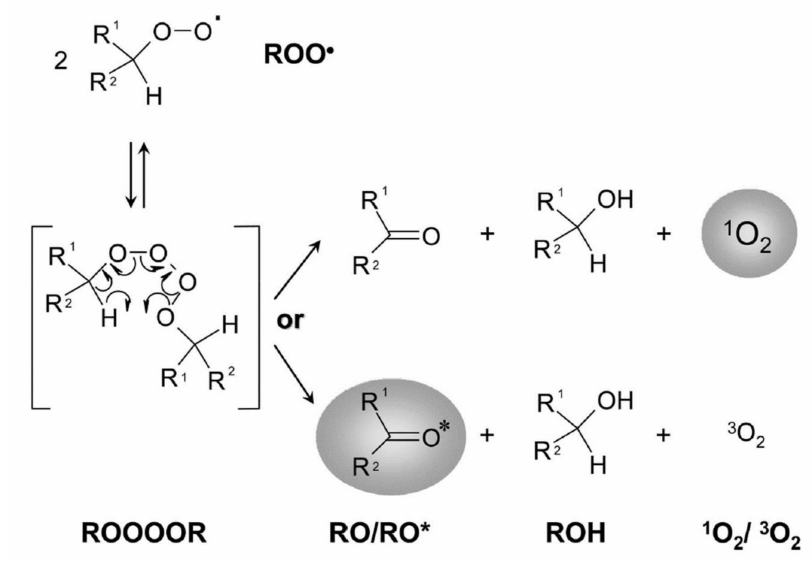
Figure 5. Russell mechanism for the bimolecular reaction of primary and secondary peroxyl radicals (ROO · ). Adopted with permission from [9]. Copyright 2007, John Wiley &